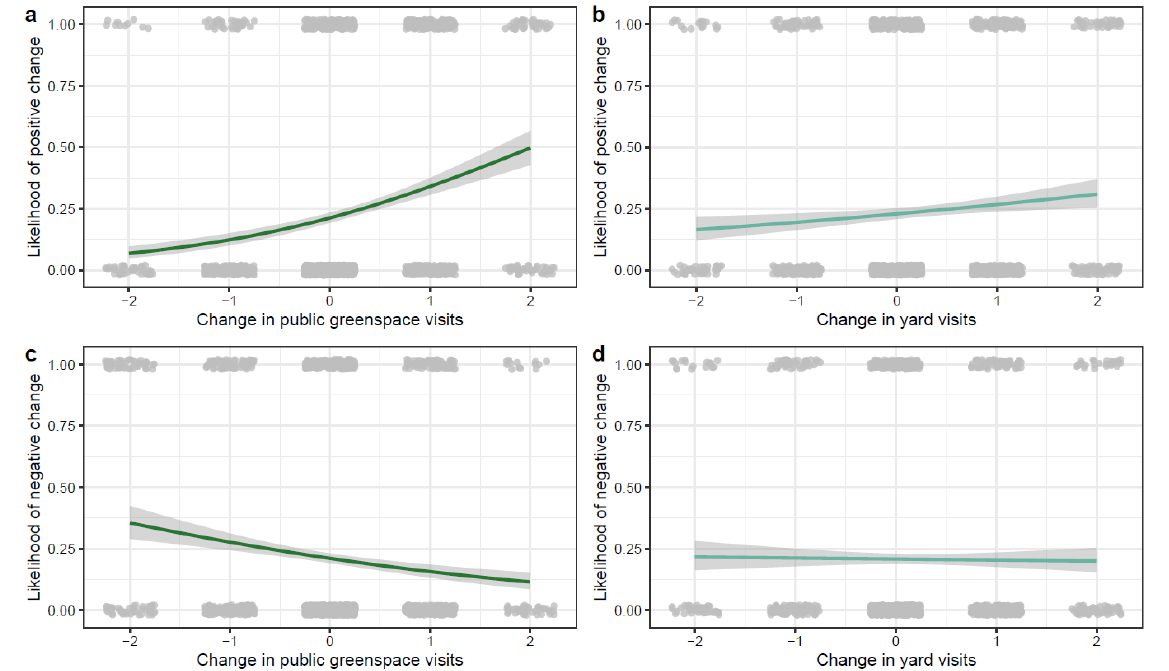
Figure 2. Likelihoods of change based on green space and yard visits: People who increased their ( a ) public green space and ( b ) yard visits over the year were more likely to have positive change in health and wellbeing. Consistently, people who increased their public green space visits compared to last year were less likely to have negative change in health and wellbeing ( c ), but this pattern was not seen in changes to yard visits ( d ) −2 = much less, −1 = less, 0 = same, 1 = more, 2 = much more.